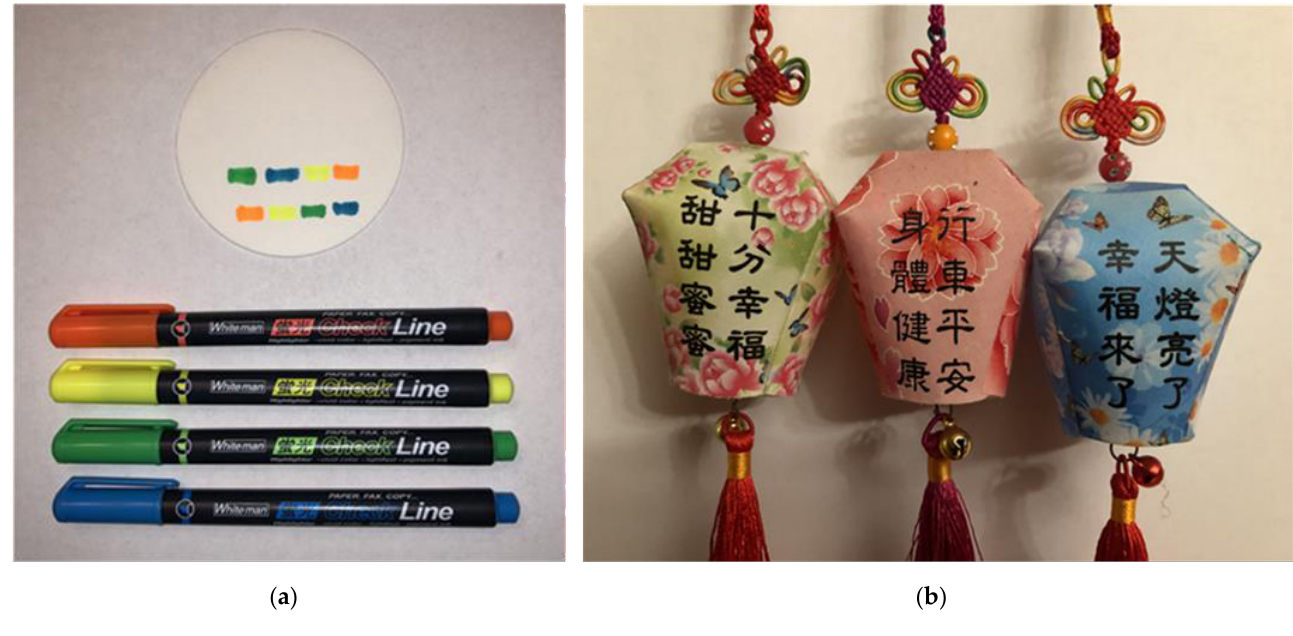
Figure 1. ( a ) Highlighter color pens and white filter papers used for chromatography experiments.; ( b ) decorative lights with randomly blinking LEDs used for dynamic colorimetric image analysis.